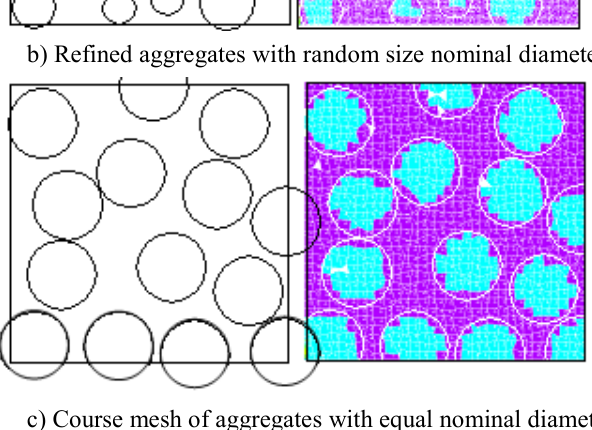
Fig. 4. Typical models of random stone